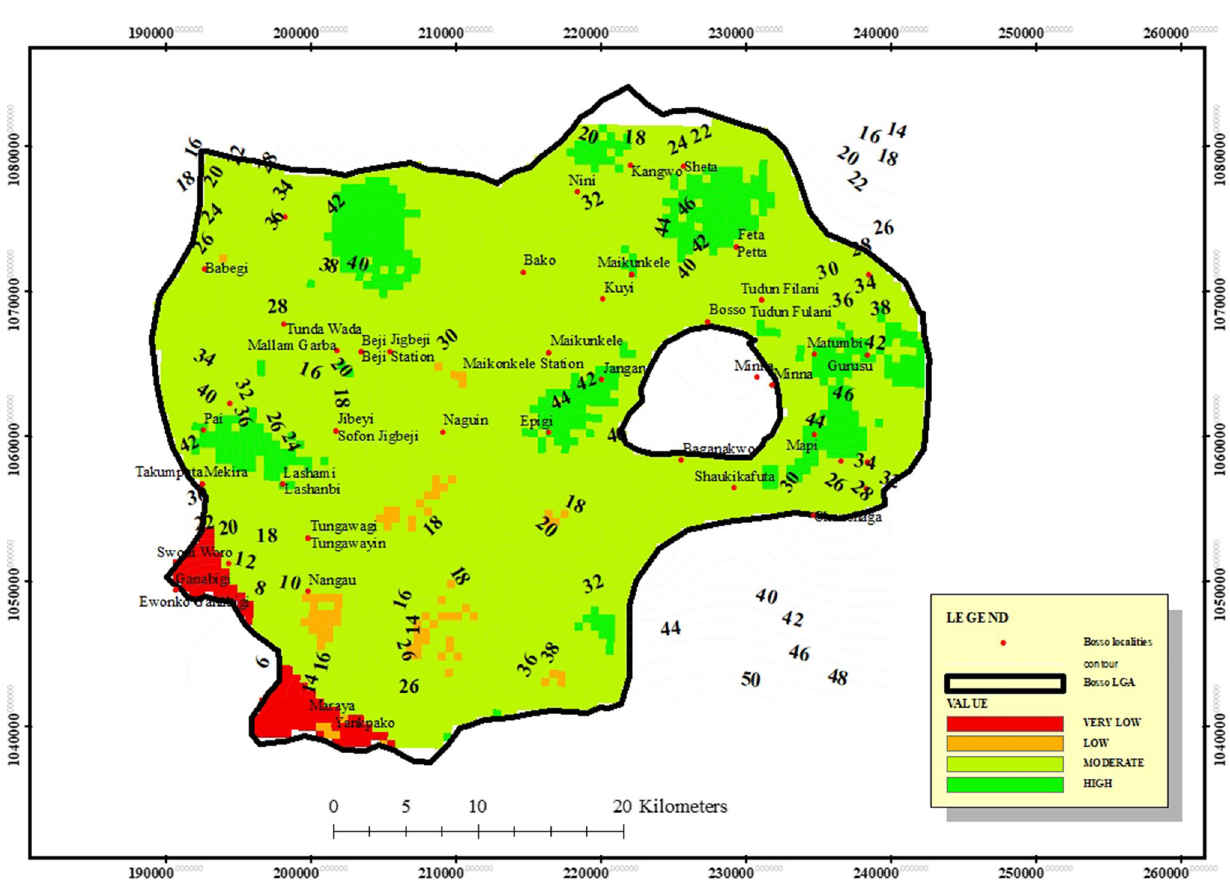
Fig. 12 Map showing an overlay of GWPM and DB contour values distribution Table 10 Correlations Hydrogeophysic